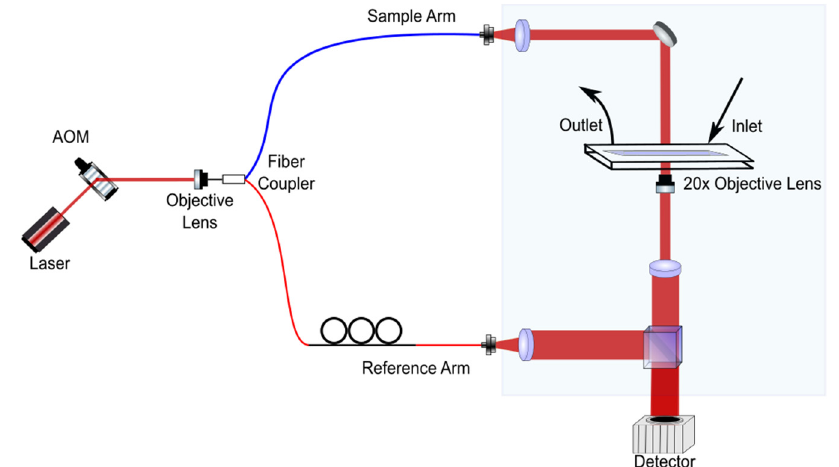
Figure 2. Holographic cytometry for high-throughput imaging.